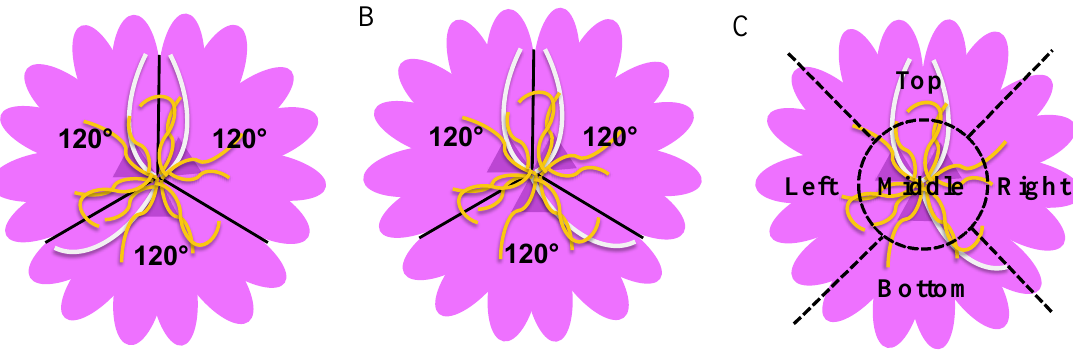
F IGURE 2. Floral illustration of Allionia incarnata L. (A) and (B): Typical display of flowers, anthers (yellow), and stigmas (white). Each flower provides 120 ⁰ of the 360 ⁰ blossom. This third style will be either (A) left- or (B) right “handed”. (C): Division of the blossom into 5 “positions” in which a pollinator can land: top, bottom, left, right, and middle.